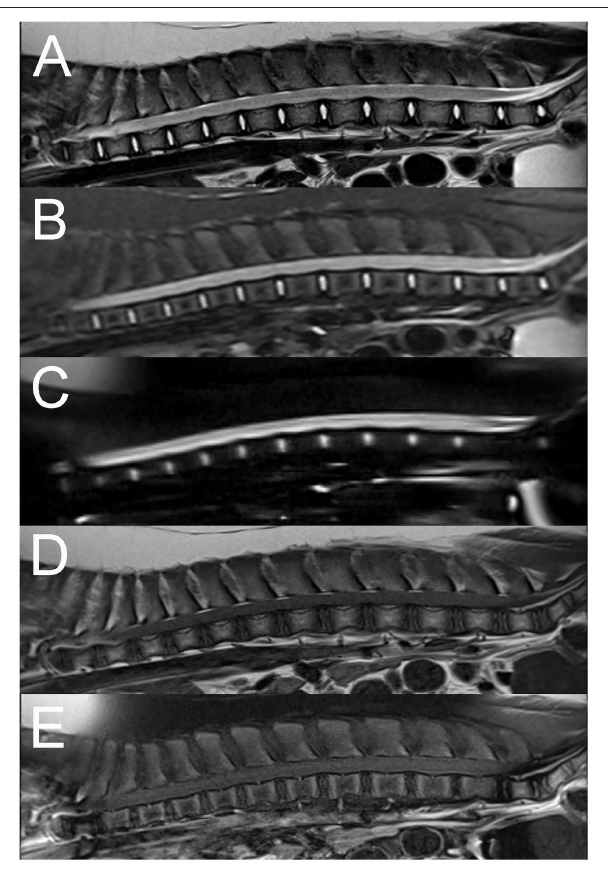
FIGURE 3 | Sagittal T2W (A) , STIR (B) , HASTE (C) , pre (D) , and post contrast T1W fat saturated (E) images of the thoracolumbar vertebral column in a 6-month old pig with complete sensorimotor loss 4 days after jumping off the bed (Case 3). There is extensive diffuse intramedullary T2W and STIR hyperintensity compared to normal spinal cord parenchyma and spinal cord swelling associated with circumferential attenuation of the subarachnoid space throughout the entire length of the thoracolumbar vertebral column (A–C) . The intramedullary lesion is isointense to the spinal cord on T1W images (D) with no evidence of abnormal contrast enhancement (E) . The findings were suggestive of myelomalacia, likely secondary to a spinal cord contusive injury.